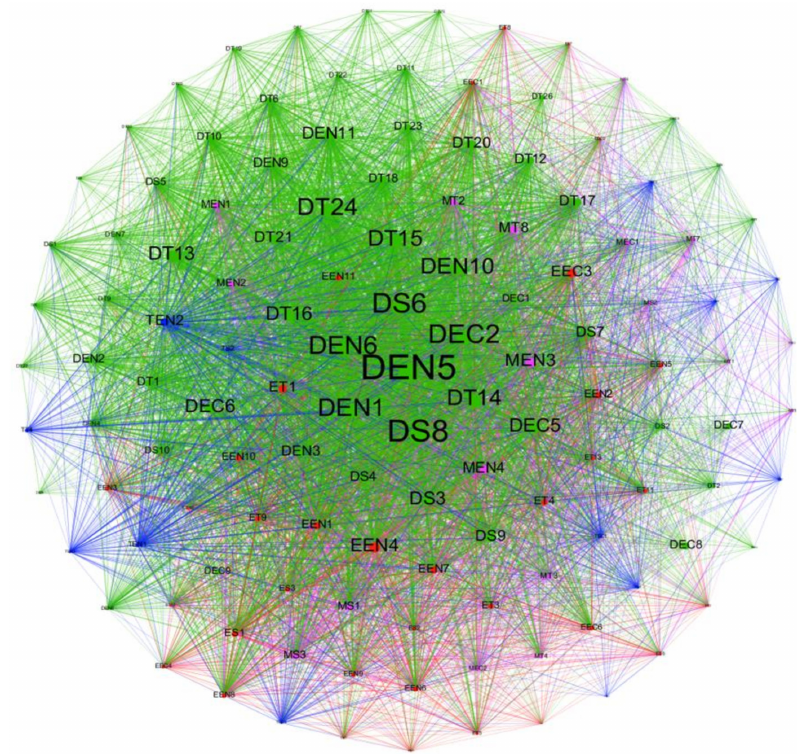
Figure 4. Clustered SIAH CSFs network.